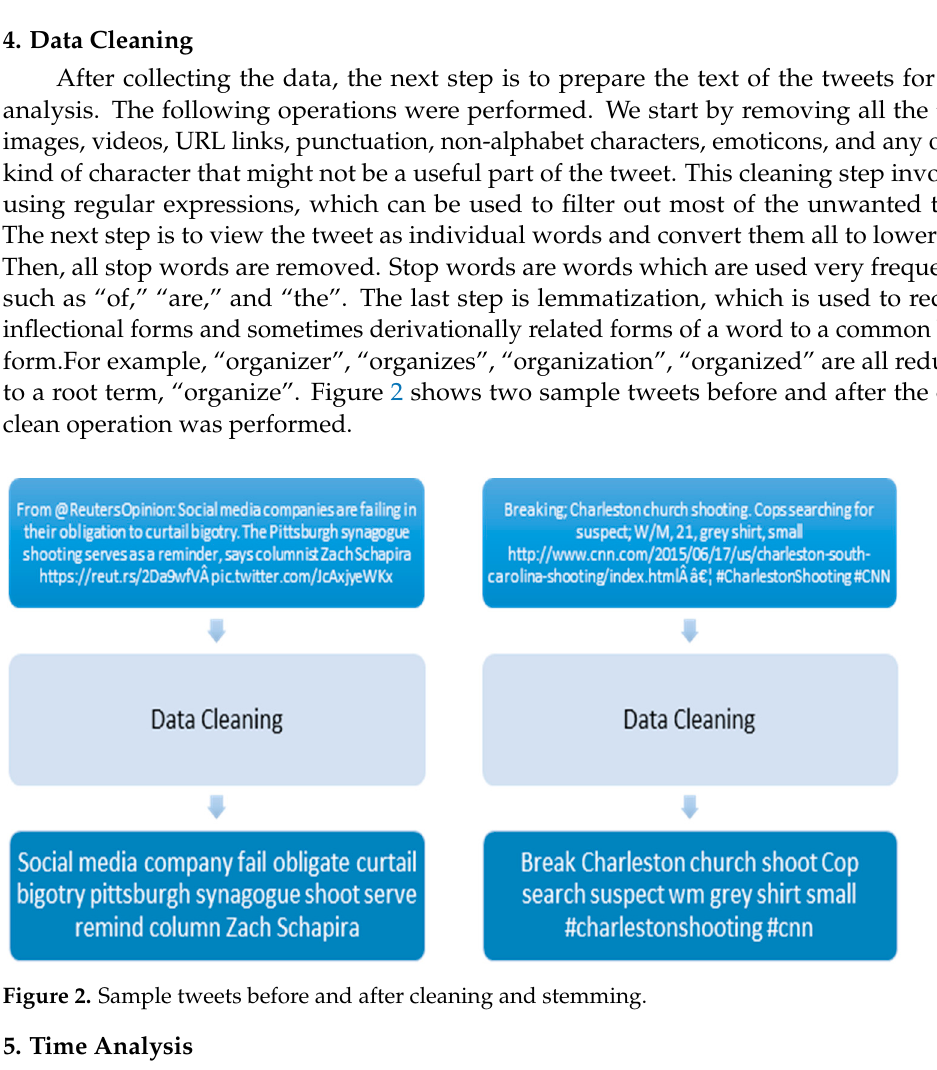
Table 3. Role of influencers in the discussion.